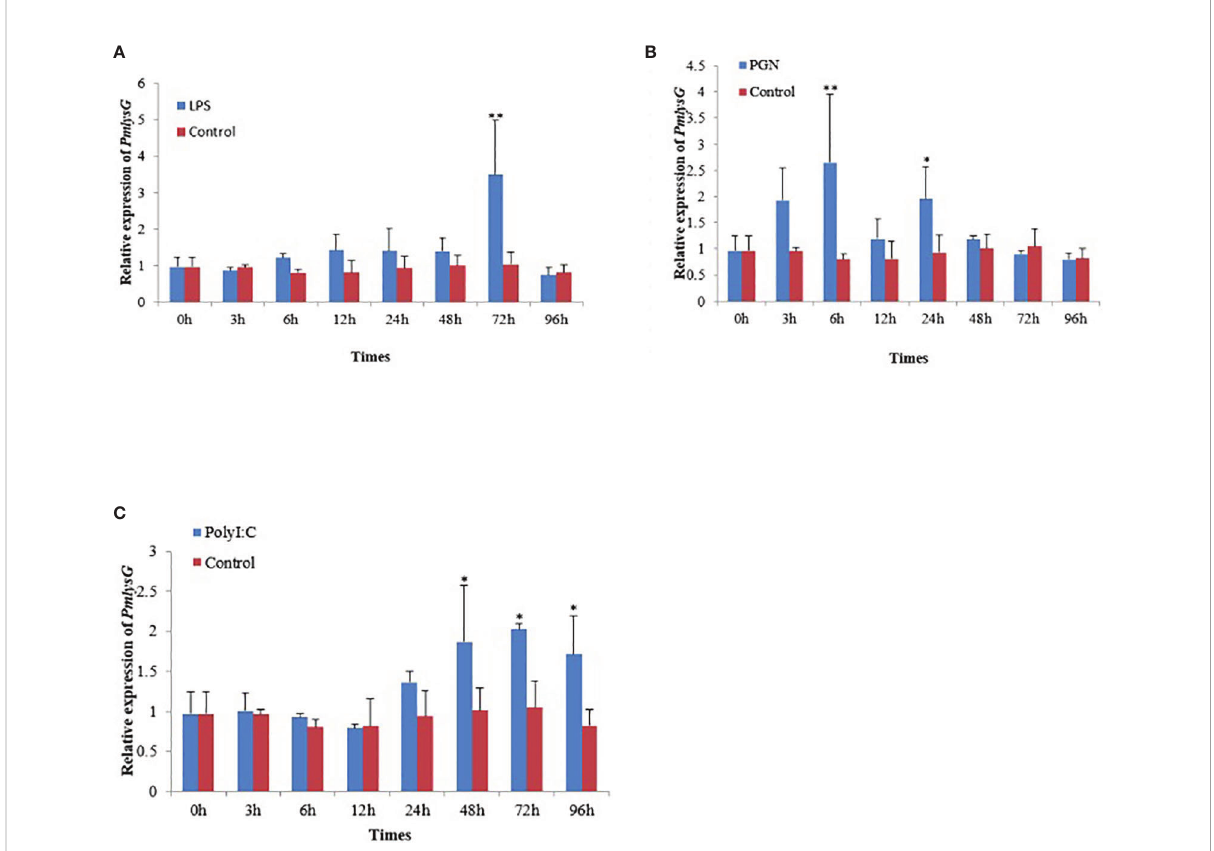
FIGURE 5 The PmlysG mRNA expression level in the hepatopancrease of P.f martensii after PAMPs stimulation. (A) LPS stimulation. (B) PGN stimulation, (C) PolyI: C stimulation. The asterisks *, P < 0.05, **, and P < 0.01 indicate signi fi cant differences between the control and stimulation groups. Vertical bars represent the mean ± SD